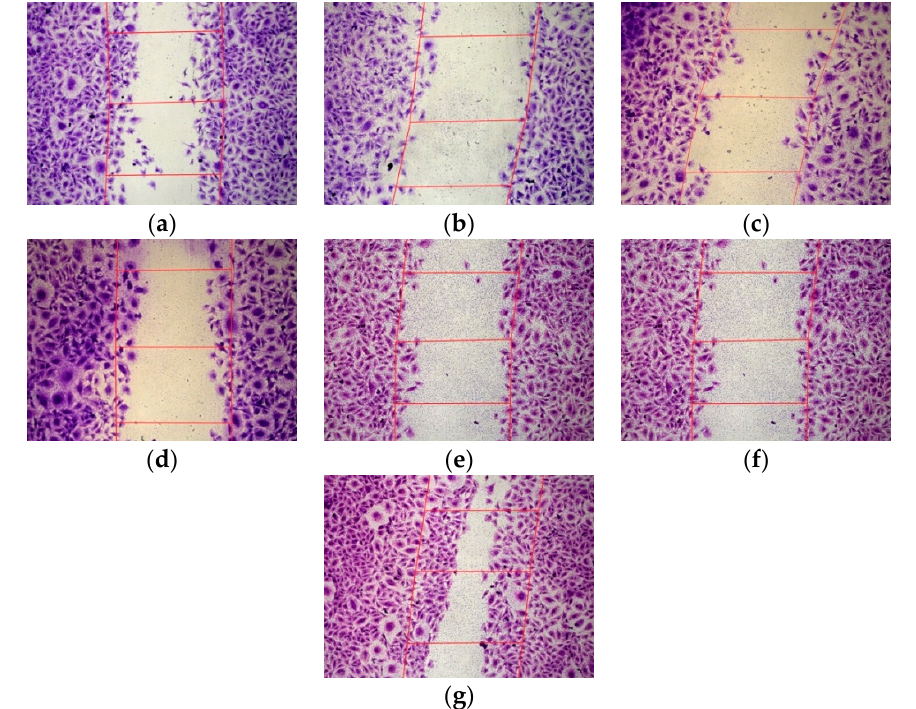
Figure 4. Appearance of migrated ЕА .Hy926 cells (magnification ×100) after treatment with ( a ) L1/mock siRNA,( b ) L1/anti-VEGFA siRNA, ( c ) L1/anti-VEGFR1 siRNA, ( d ) L1/anti-endoglin siRNA, ( e ) L1/anti-VEGFA siRNA + anti-VEGFR1 siRNA, ( f ) L1/anti-VEGFA siRNA+anti-endoglin siRNA complexes (200 nM siRNA), and ( g ) intact cells.